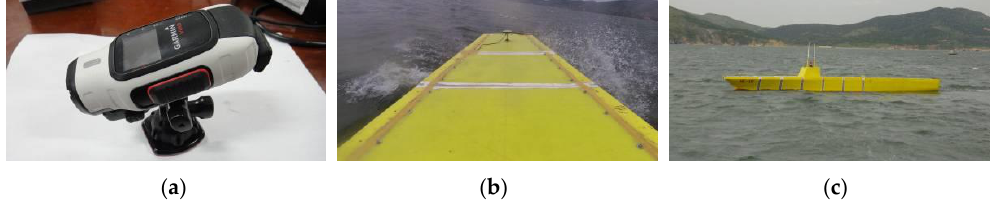
Figure 24. Video recording: ( a ) the on deck video camera; ( b ) view from the model; and ( c ) view from the yacht.